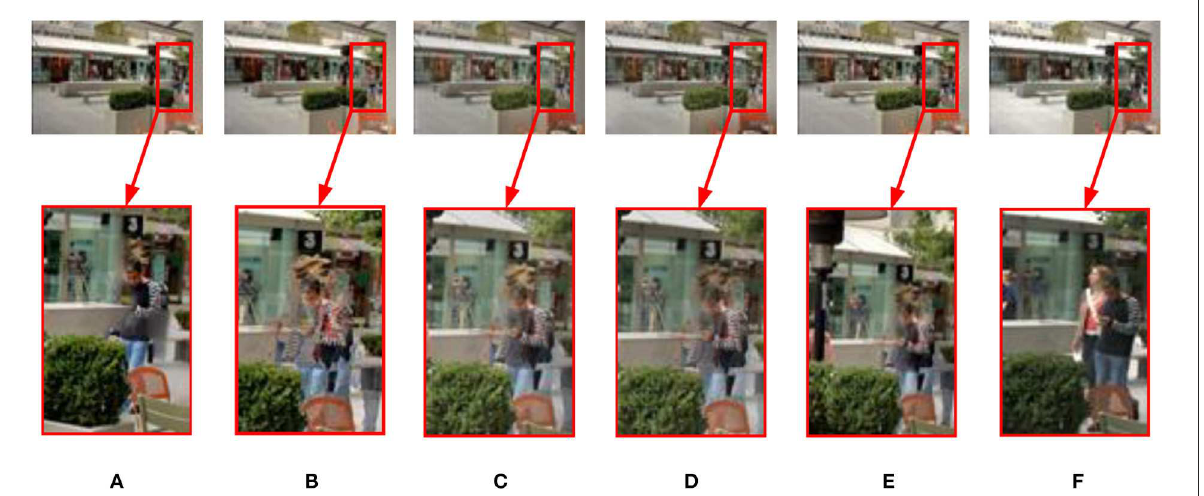
FIGURE8 On dynamic “Cliff” image sequence, the available MEF methods compare with the proposed method. (A) Hayat and Imran (2019); (B) Mertens et al. (2007); (C) Li and Kang (2012); (D) Liu and Wang (2015); (E) Lee et al. (2018); (F) the proposed method in this study.